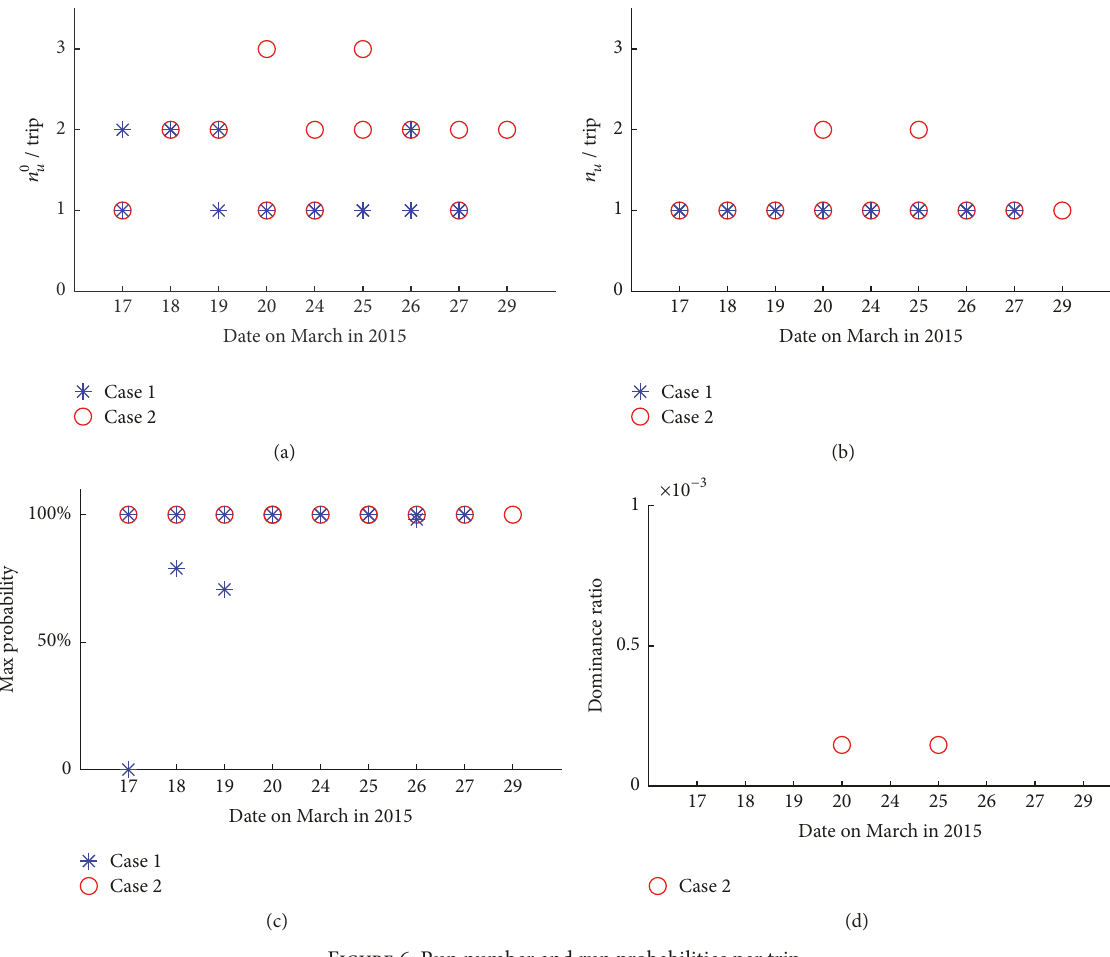
Figure 6: Run number and run probabilities per